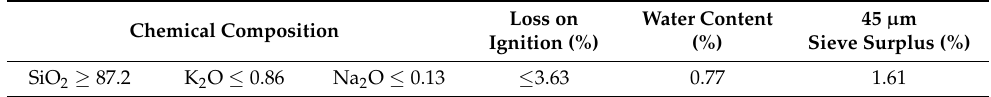
Table 2. Chemical composition and physical properties of silica fume.